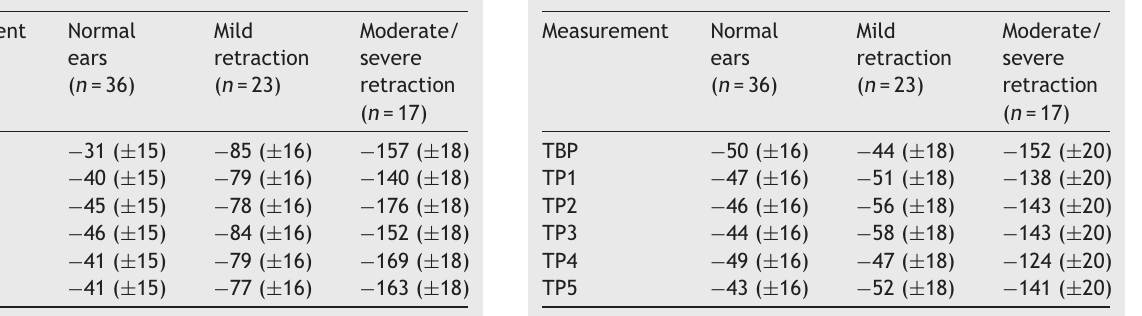
Estimated means obtained with a linear mixed model for the Toynbee maneuver in the three study groups, at the first time point of assessment.